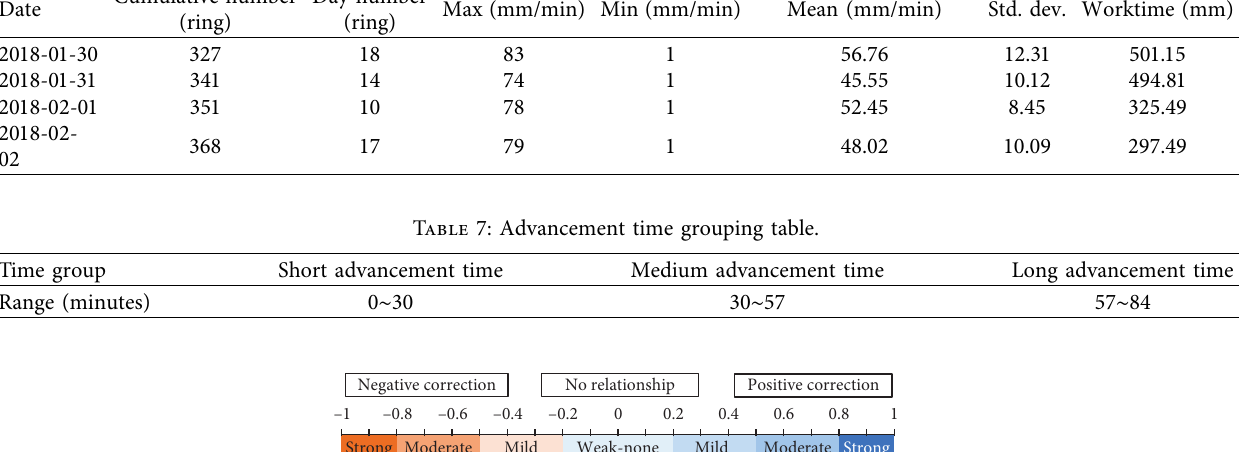
Figure 9: Correlation coefficient analysis chart of each group.